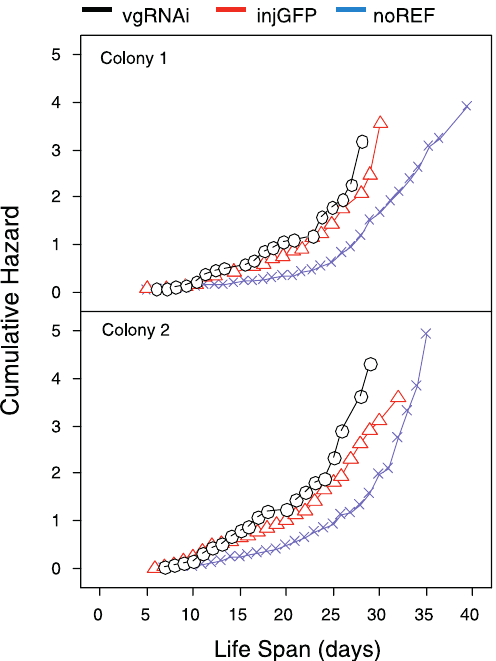
Figure 4. Effect of vitellogenin Gene Activity on Lifespan Cumulative hazard increases until all bees have died. Injected controls (injGFP) lived longer than knockdowns (vgRNAi; LRT ¼ 4.38, df ¼ 1, p , 0.036, hazard ratio [comparative survival experience calculated over the entire time of the study] ¼ 1.29 d longer, confidence interval ¼ 1.02–1.63 d). Longevity was affected by laboratory handling (LRT ¼ 43.4, df ¼ 1, p , 0.0001, hazard ratio ¼ 1.96 d longer for non-injected reference (noREF) bees compared with injGFP bees, confidence interval ¼ 1.61–2.38 d).